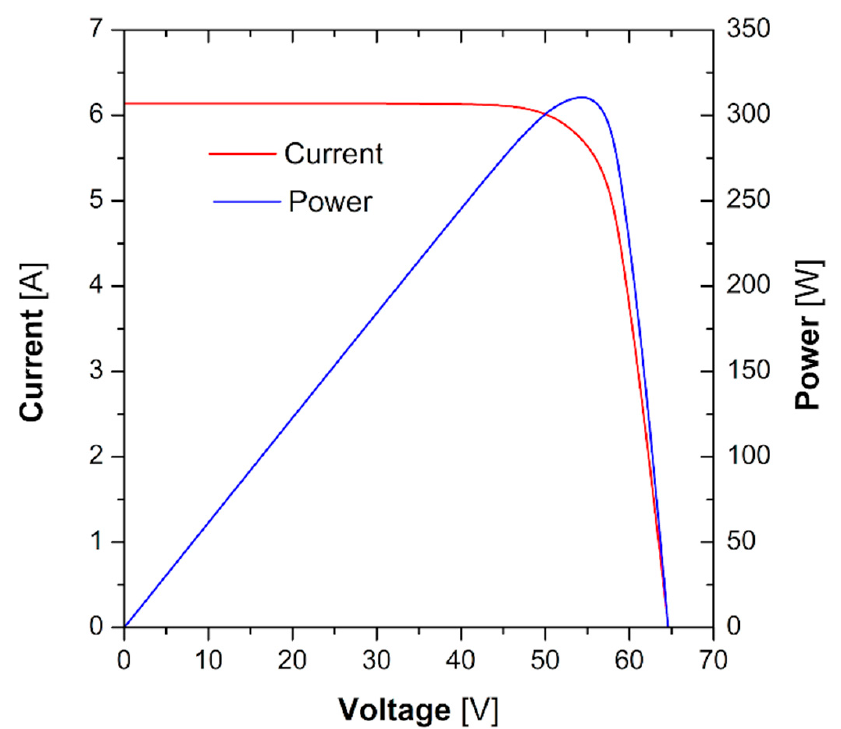
Figure 3. Characteristic curves of the photovoltaic (PV) module.